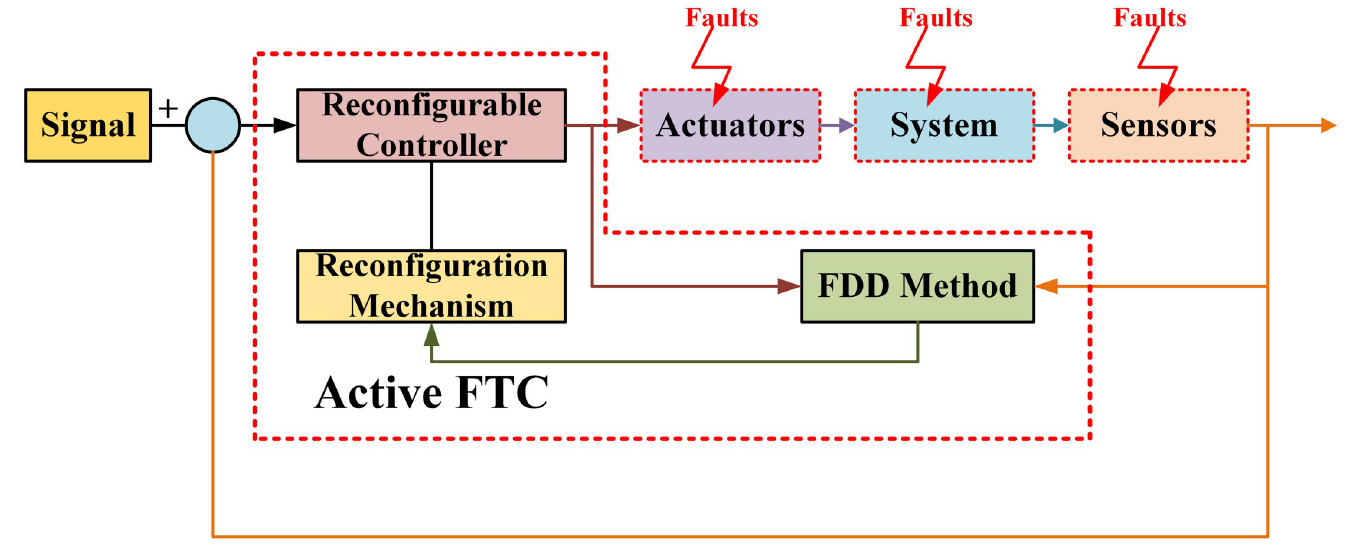
Fig 4. Active FTC